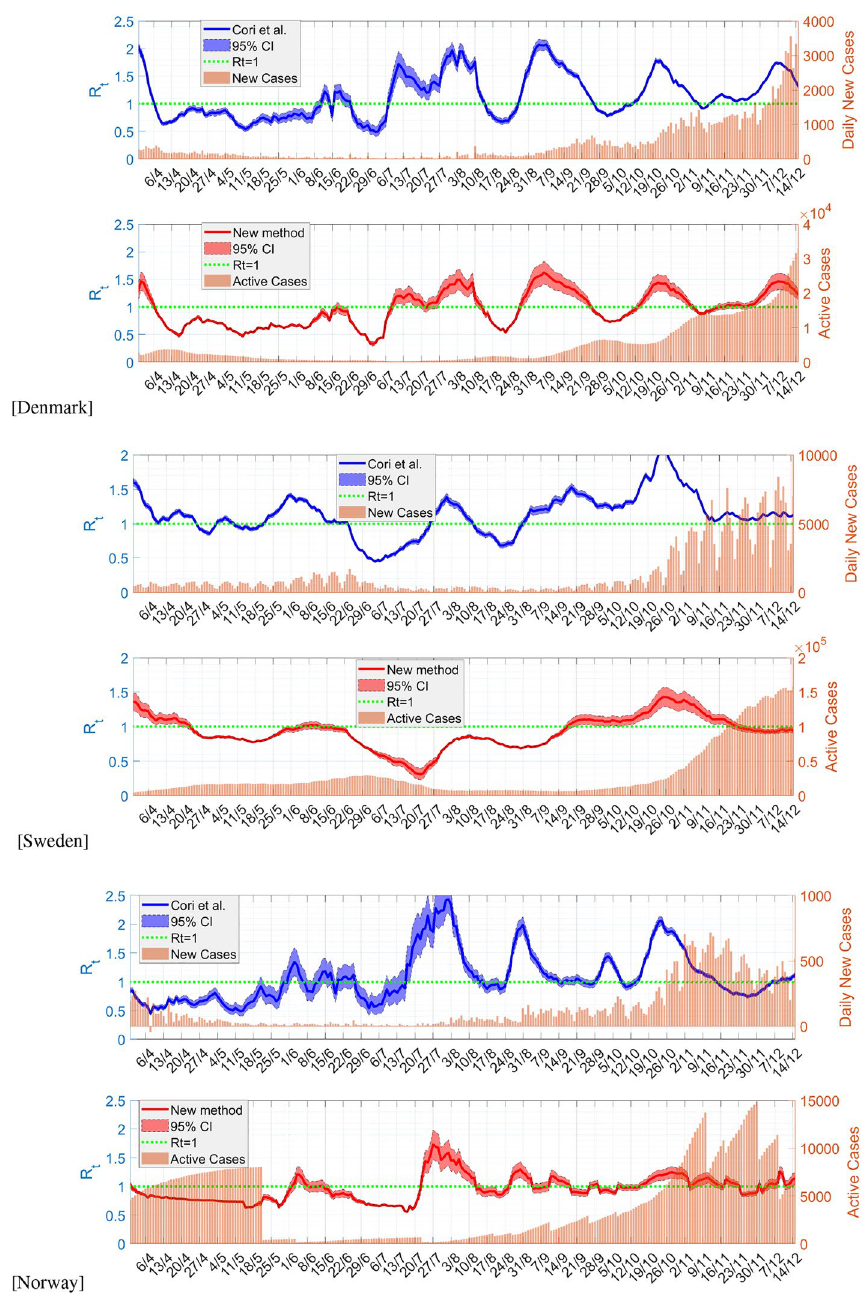
Figure 3. Comparison of the estimated time-varying effective reproduction number between our method and Cori et al. 13